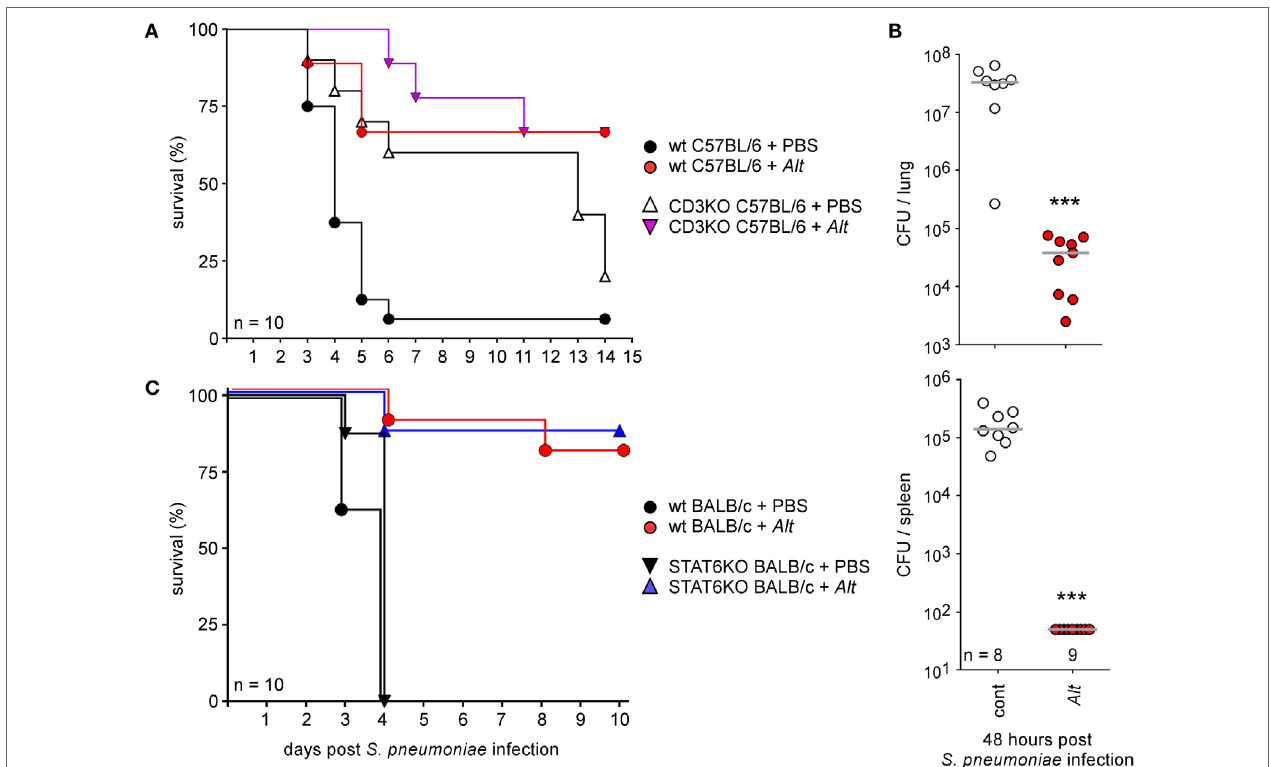
FigUre 11 | Asthma sensitization increases resistance against intranasal Streptococcus pneumoniae infection. Wild-type and CD3 − / − C57BL/6 (a,B) and wild-type and STAT-6 − / − BALB/c mice (c) were sensitized with phosphate-buffered saline (cont) or Alt before i.n. infection with a lethal CFU dose (2 × 10 7 CFU) of S. pneumonia, as indicated in the legend of each graph. (a,c) The data shown are the percentage of mice surviving infection at a given time. (B) The data represent the number of CFU per lung or spleen, as indicated. n indicates the number of mice per group. These results are representative of at least two independent